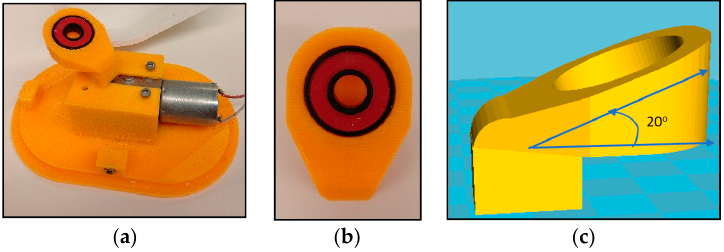
Figure 3. Bearing holder printed with polylactic acid (PLA). ( a ) in base; ( b ) detail; ( c ) FreeCAD side view showing 20° tilt angle. view showing 20° tilt